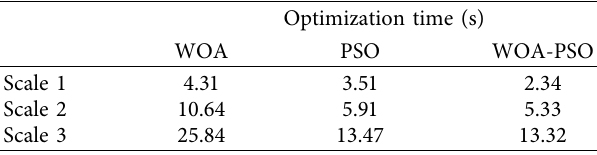
Figure 7: Scale 3 (60 Table 1: Optimization time comparison among different algorithms.